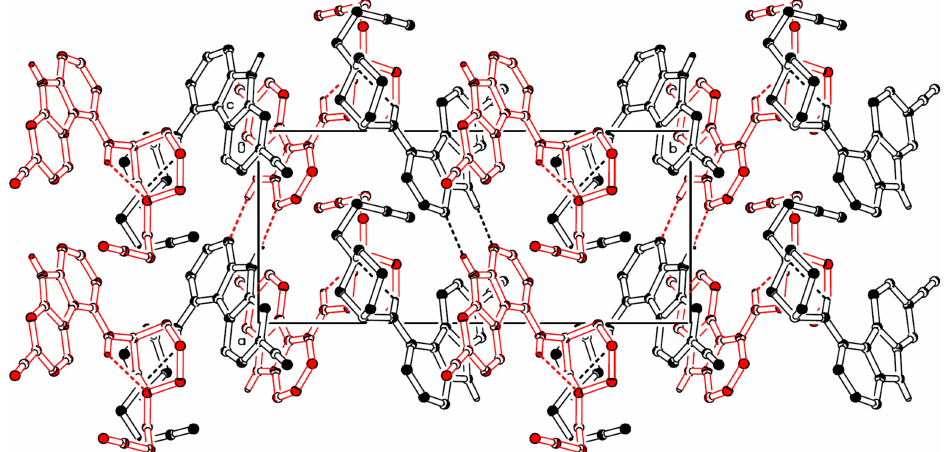
Figure 3. Partial packing diagram of title compound 2 . Hydrogen bonds are depicted as dashed lines.